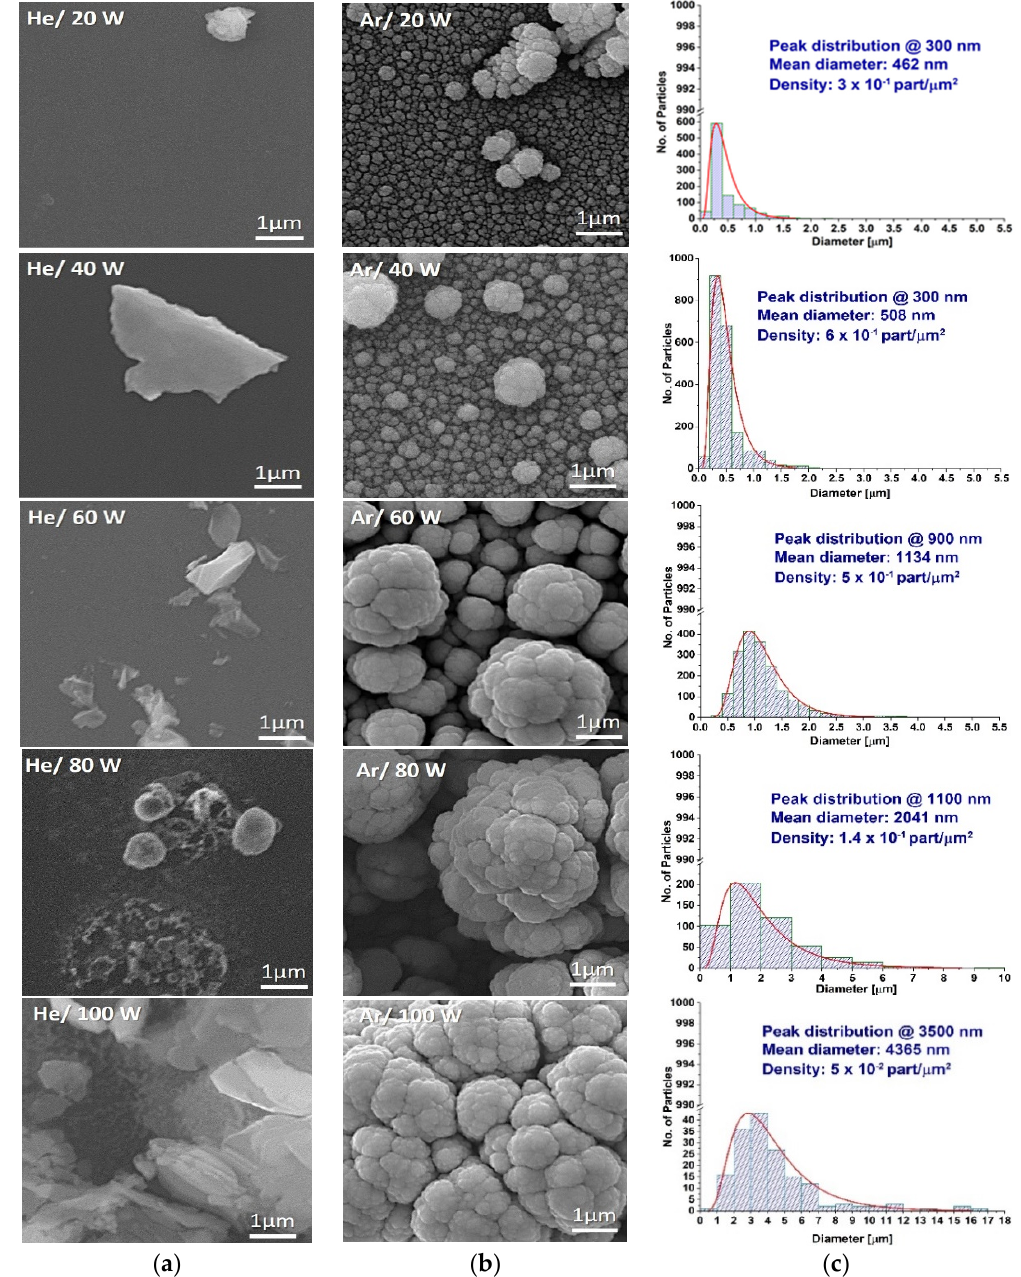
Figure 14. SEM images of W dust obtained in Microjet Discharge: ( a ) He discharge; ( b ) Ar discharge; and ( c ) Particles size distributions for Ar discharge.